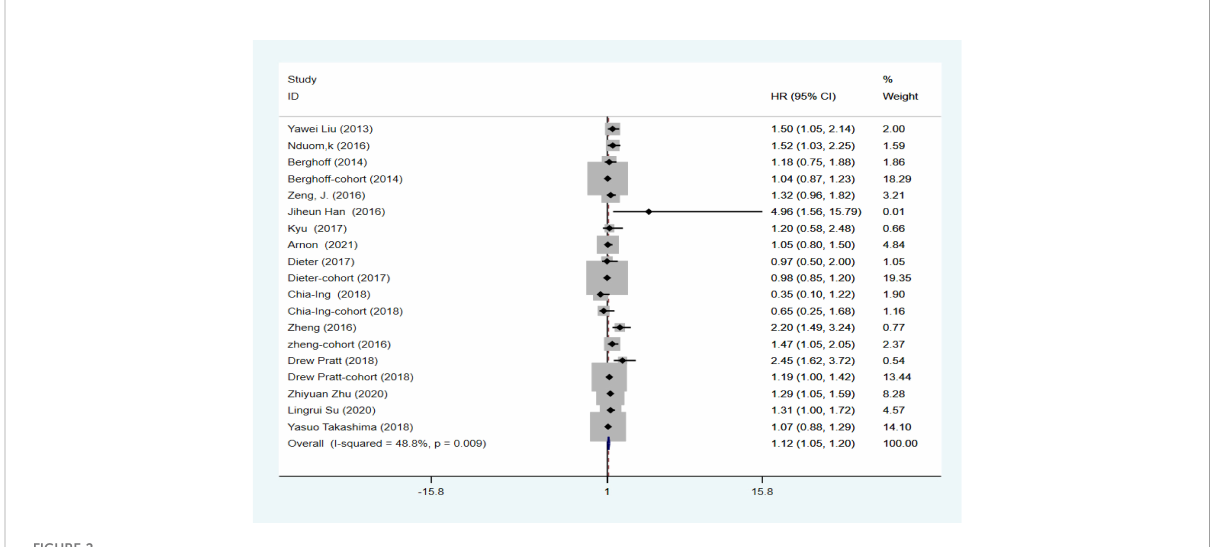
FIGURE 2 Association between PD-L1 expression and OS of GBM